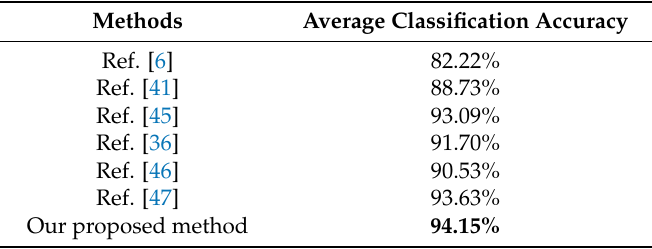
Table 3. Comparisons of the average classification accuracy on MSR-Action3D dataset.